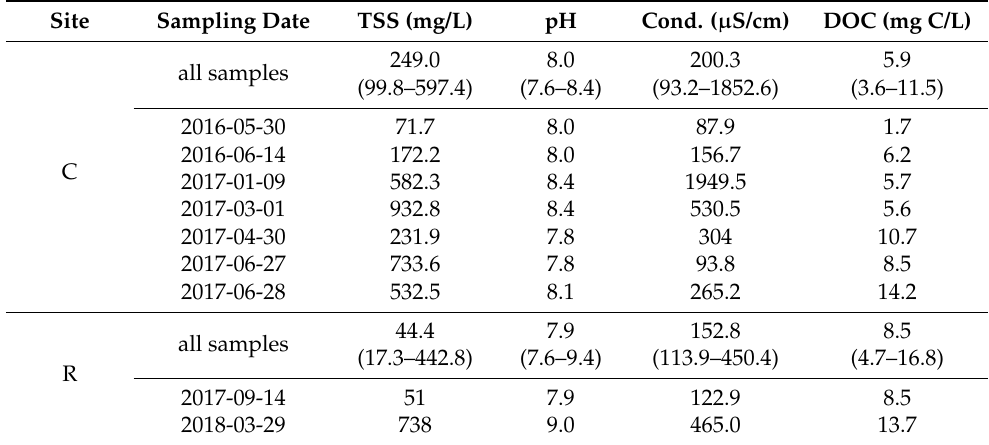
Table 1. Physico-chemical characteristics of runoff samples: median, (C10–C90) concentrations for all samples collected during the campaigns [9], with a focus on those characterized by HRMS and ecotoxicity (corresponding dates are indicated). TSS = total suspended solids; Cond. = conductivity; DOC = dissolved organic carbon; C = Compans site; R = Rosny